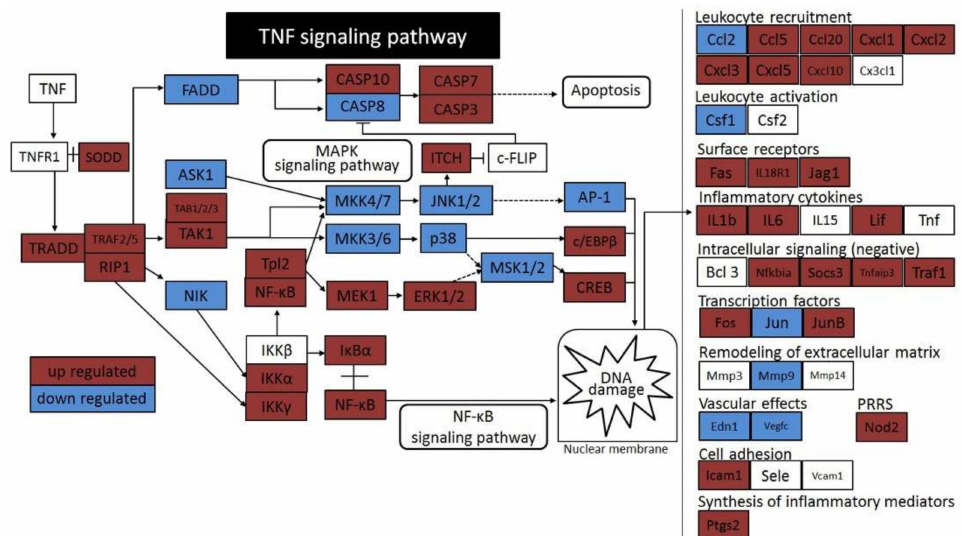
Figure 3. Schematic representation of deoxycholic acid (DCA) cytotoxicity mediated by the activation of the TNF signaling pathway. Solid arrows indicate direct interactions and broken arrows indicate indirect effects. Red represents statistically significant upregulation and blue represents statistically significant downregulation ( p ≤ 0.05). Abbreviations: AP-1, activator protein-1; ASK1,